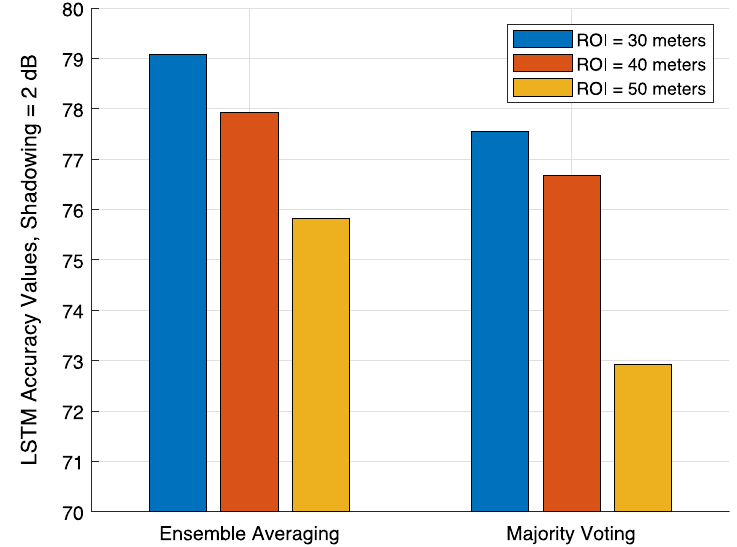
Fig. 4 LSTM accuracies at 2 dB shadowing